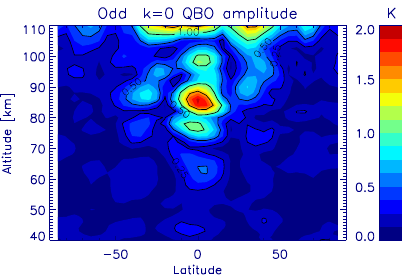
Figure 15. QBO amplitudes derived from the MIPAS | n odd − s | = 0 longitudinal mode extracted from monthly means from April 2007 to March